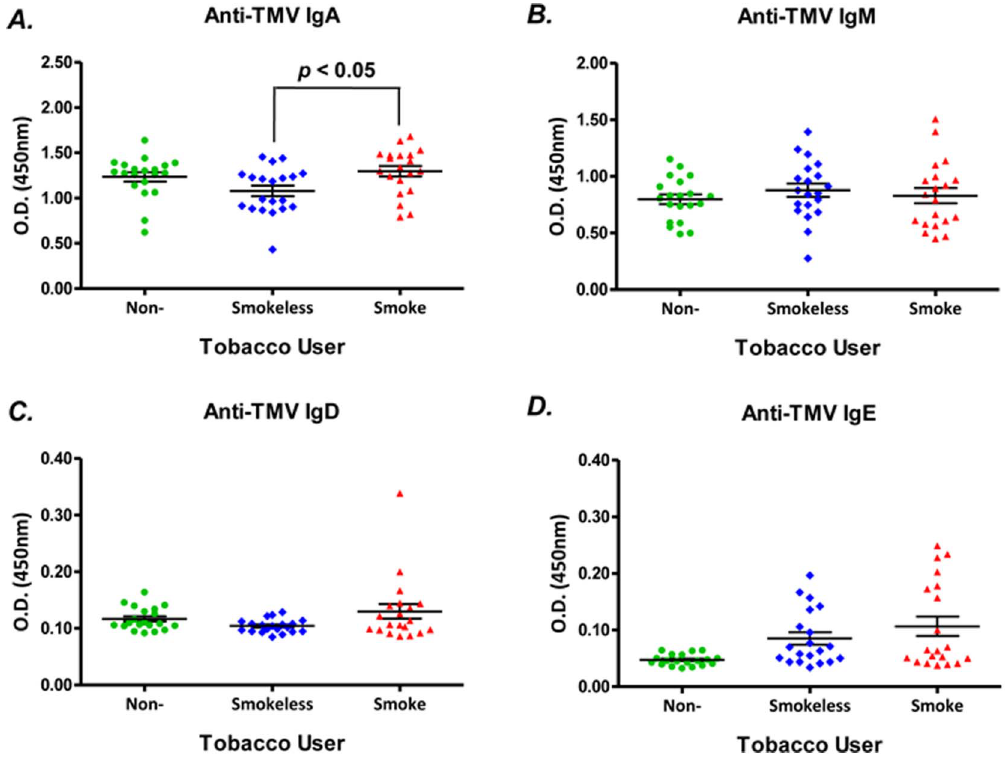
Figure 2. Effects of tobacco-smoke and smokeless-tobacco exposure on serum anti-TMV IgA, IgM, IgD and IgE. Sera were obtained from groups of smokers, smokeless tobacco users and non-tobacco users (n=20/group). Serum anti-TMV IgA, IgM, IgD, and IgE levels were measured by a customized sandwich ELISA assay. The serum dilution factors were 1:50 for anti-TMV IgA and IgM and 1:5 for anti-TMV IgD and IgE. Data is expressed as O.D. values (mean 6 SE). All data are representative of two to three assays with similar results. (A) Serum anti-TMV IgA in whole study population; (B) Serum anti-TMV IgM in whole study population; (C) Serum anti-TMV IgD in whole study population; (D) Serum anti-TMV IgG in whole study population. p -value, ANOVA, * p ,